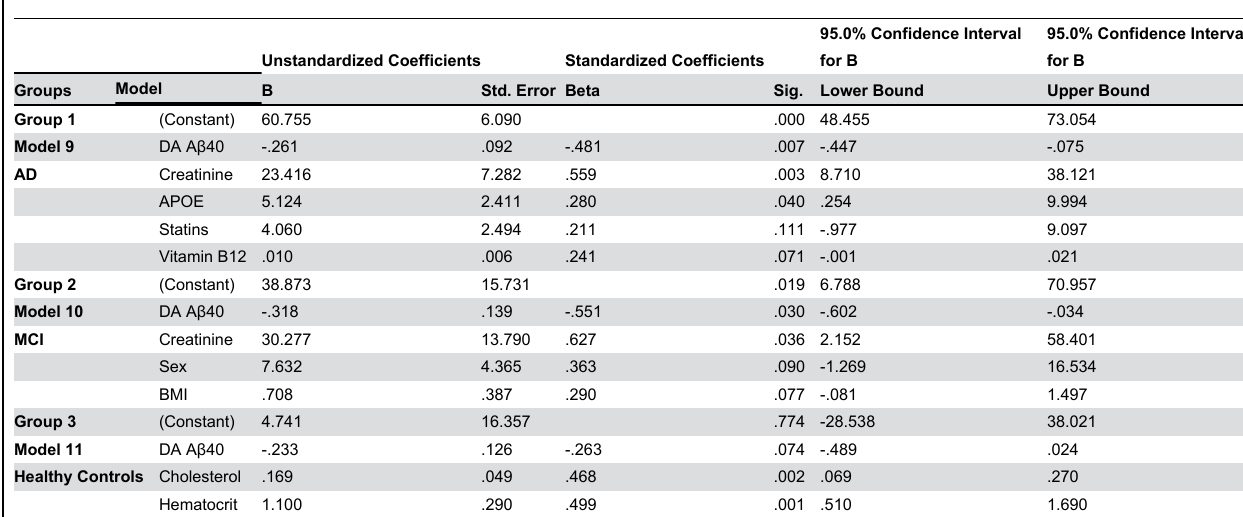
Table 4. Backward linear regression analysis exploring factors correlated with diastolic blood